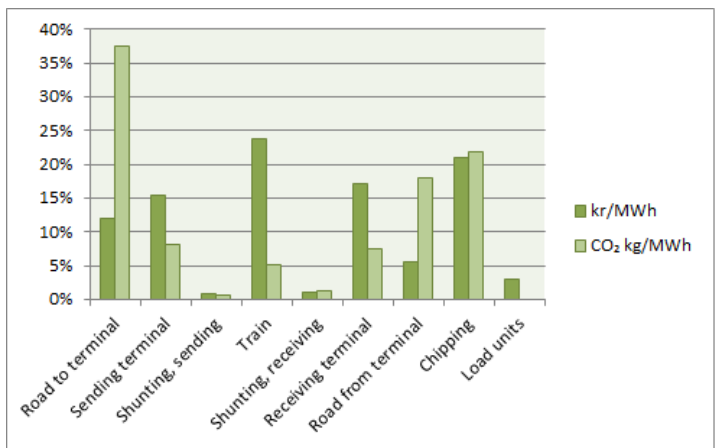
Figure 13. Distribution of costs and CO 2 emissions with pre and post-haulage.